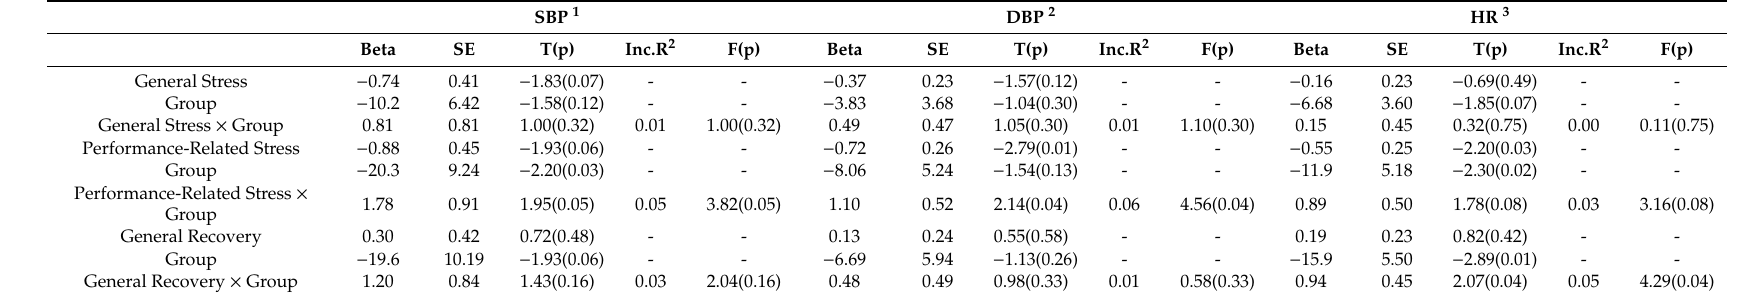
Table 3. Moderation analyses results for the prediction of SBP, DBP and HR at